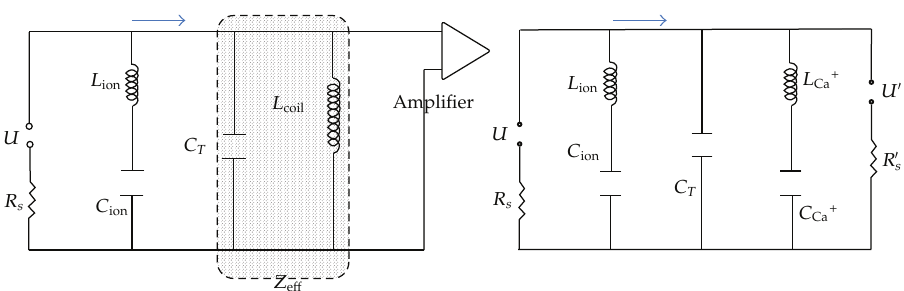
Figure 2: (cid:3) right (cid:4) Electronic equivalent of the ion in the trap attached to an external coil to apply the IIC technique. The inductance of the coil is taken so that the axial oscillation frequency of the ions in the trap is equal to the resonance frequency of the L coil C T -circuit. In this way, the circuit provides an e ff ective impedance for the induced current (cid:3) arrow in the top (cid:4) before further amplification. The system must be operated at cryogenic temperature so that the electronic noise is minimum. (cid:3) left (cid:4) Electronic representation of the two ions connected via a common endcap. The energy is transferred from the ion of interest to the sensor ion within a time according to (cid:3) 2.9 (cid:4) . The laser-cooled ion is at mK temperature and therefore more sensitive to the motion of the ion of interest. Since this is oscillating at very low energy (cid:3) equivalent to mK temperature (cid:4) , any small transfer of energy will be already